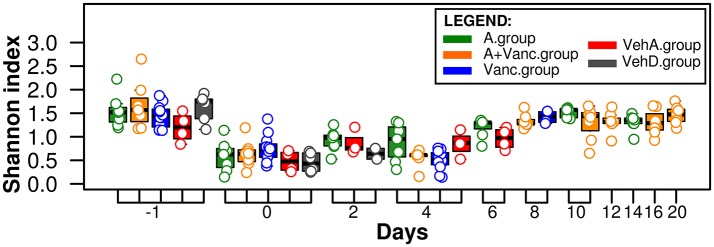
Shannon microbial diversity index. The values for each sample are visualized as colored dots according to their experimental groups (red, gray, blue, green, and orange). The microbiome of all experimental groups had the highest Shannon diversity index on day −1 and decreased significantly (p < 0.01) on day 0.